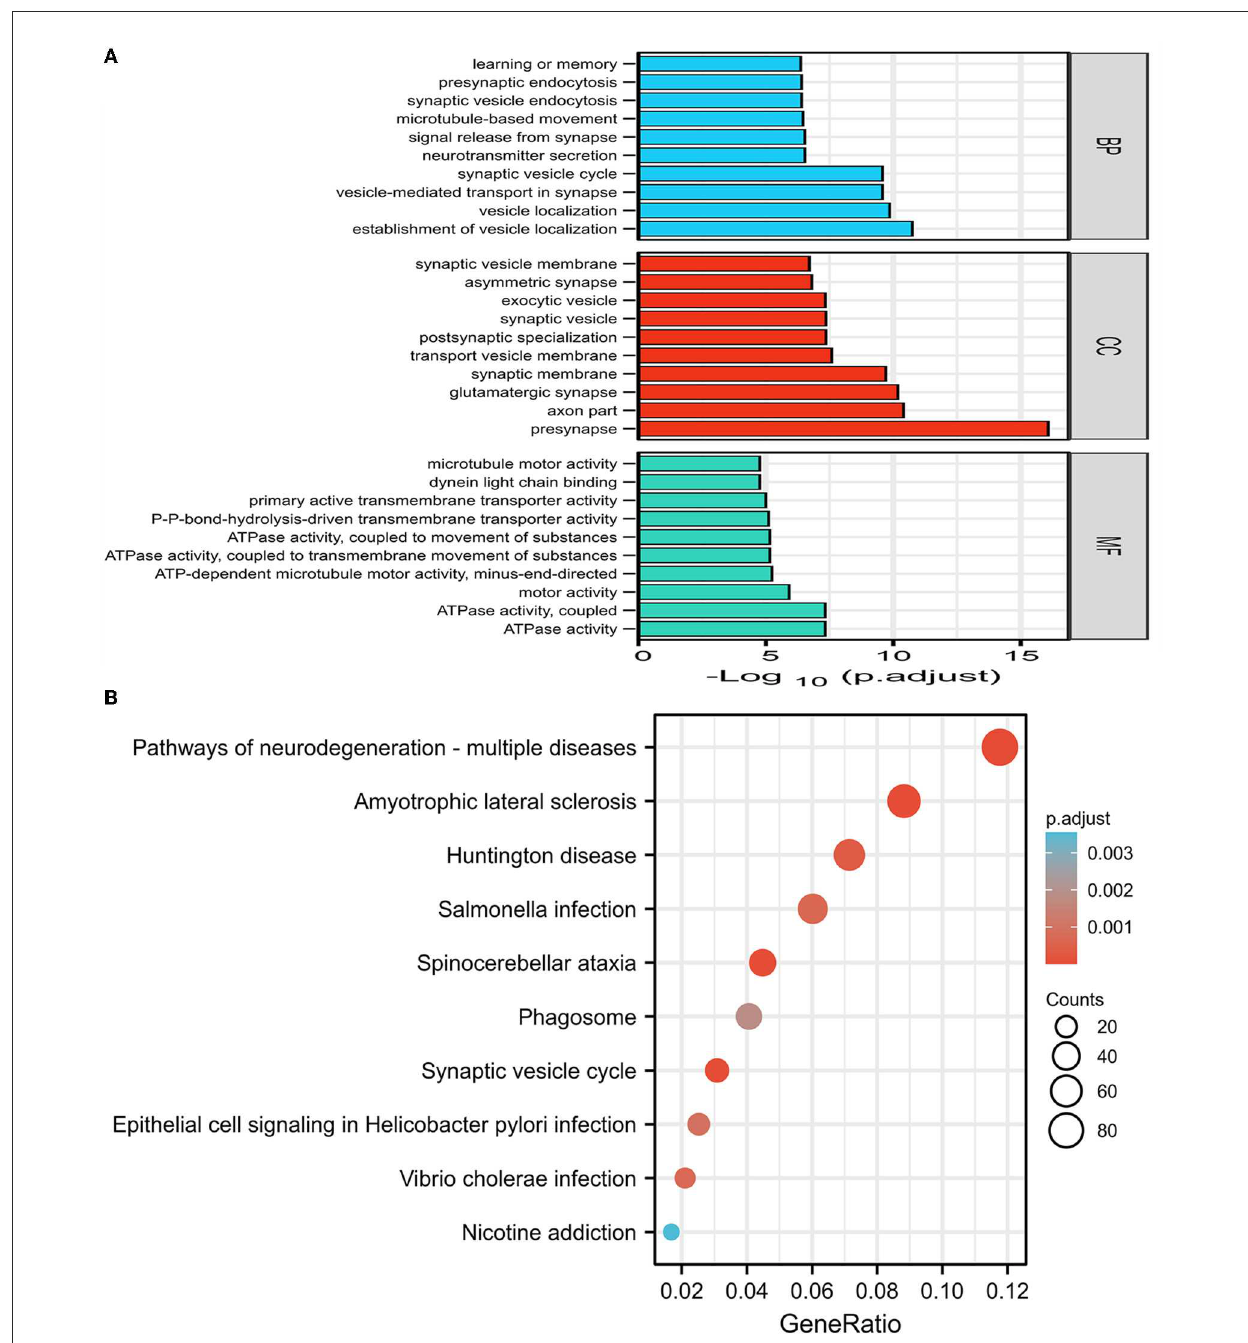
FIGURE2 (A) The results of gene ontology (GO) enrichment categories of the DEGs for both Parkinson’s disease dementia (PDD) and Dementia with Lewy bodies (DLB) groups including biological process (BP), cellular component (CC), and molecular function (MF). (B) The results of the Kyoto encyclopedia of genes and genomes (KEGG) pathway enrichment analyses of the DEGs for both PDD and DLB, the abscissa represents GeneRatio (the number of genes enriched in this KEGG entry/the total number of genes), and the ordinate represents KEGG terms. P-adjust refers to the P -value after correction, the darker the red color, the greater the correlation. Counts refer to the number of genes enriched in this KEGG entry, the larger the circle, the more the number of genes.